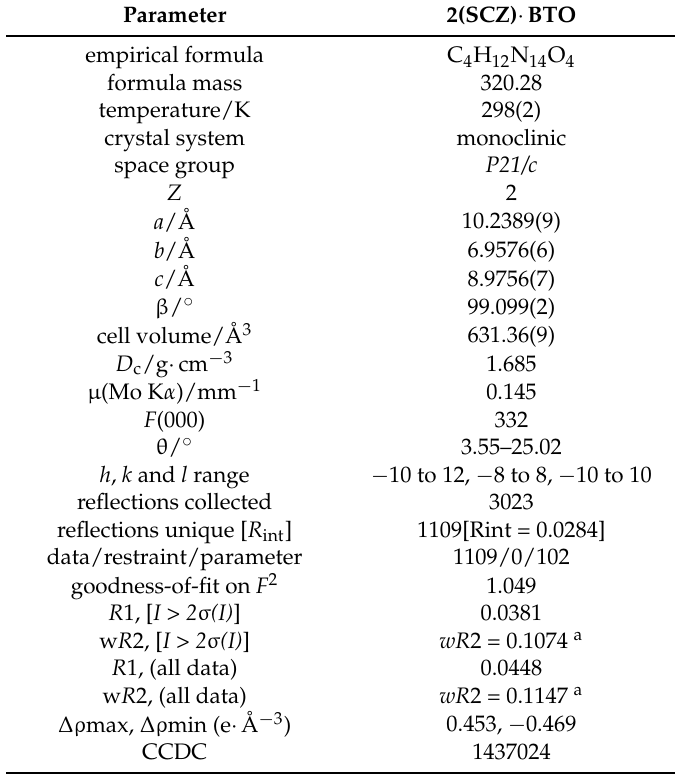
Table 1. Crystal data and structure refinement details for salt 2(SCZ) ∙ BTO.